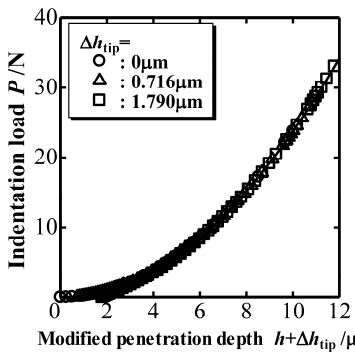
Figure A3. Indentation load P vs. modified penetration depth h + Δ h tip curves obtained with truncated conical indenters.